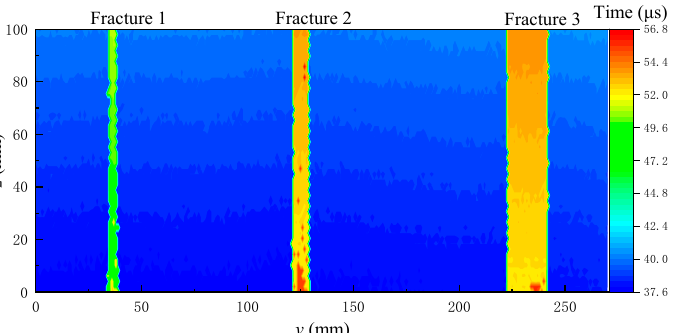
Figure 19. Echo arrival time imaging diagram for grooved sandstone Plate 1.